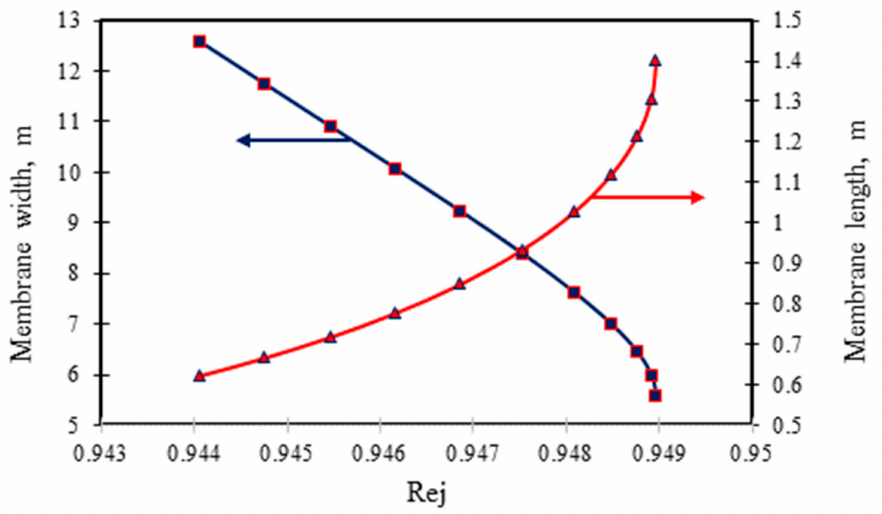
Figure 5. Influence of membrane module design parameters (length and width) on the re- moval of dimethylphenol at fixed membrane area and feed channel height (operating parameters: ( B ) 0.819 × 10 − 3 kmol/m 3 , 2.166 × 10 − 4 m 3 /s, 5.83 atm, and 32.5 ◦